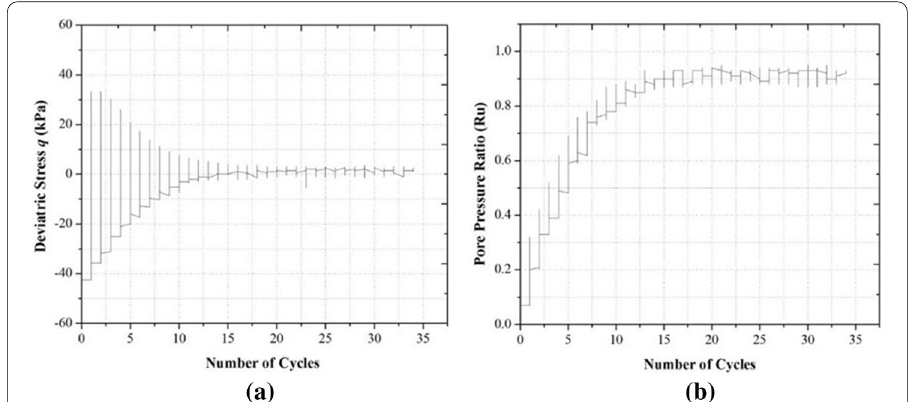
Fig. 5 a Variation of deviator stress with number of loading cycles. b Variation of pore pressure ratio with number of cycles (Allahabad soil, RD